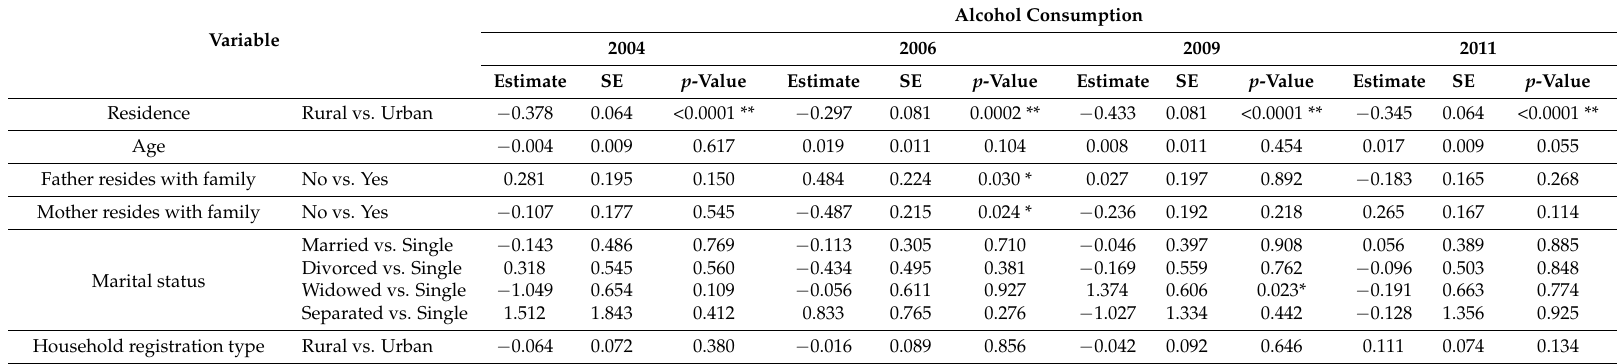
Table 4. Penalized logistic regression analysis of alcohol consumption among adult women of reproductive age (continuous